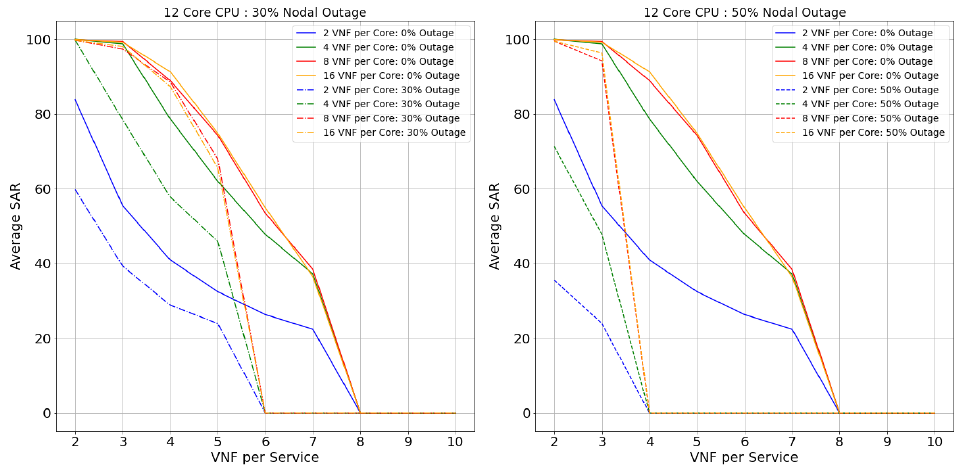
Figure 16. SAR: Netrail topology with nodal outage—12 Core